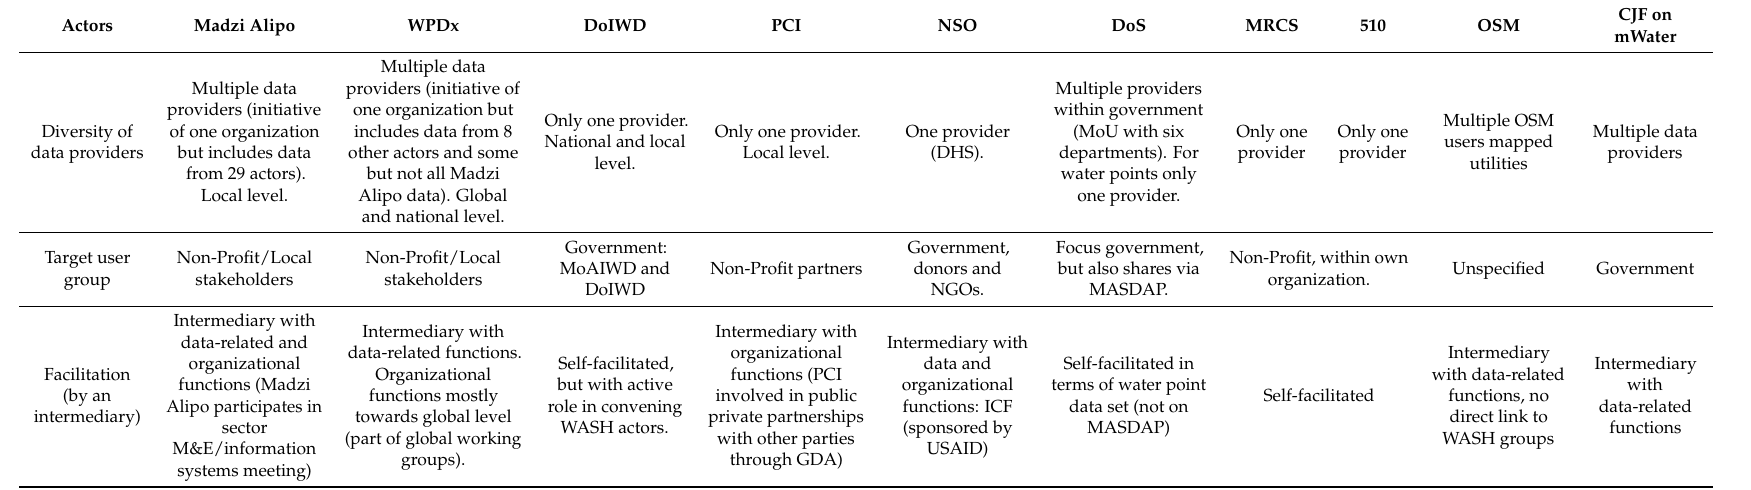
Table 3. The actor dimension of the data ecosystem framework for Malawi on SDG 6.1.1. WPDx Water Point Data Exchange; DoIWD Department of Irrigation and Water Development; PCI Project Concern International; DoS Department of Surveys; MRCS Malawi Red Cross Society; OSM OpenStreetMap; CJF Climate Justice Fund; MoAIWD Ministry of Agriculture Irrigation and Water Development; GDA Global Development Alliance, MoU Memorandum of Understanding, MASDAP Malawi Spatial Data Platform, DHS Demographic Health Survey; NSO National Statistics